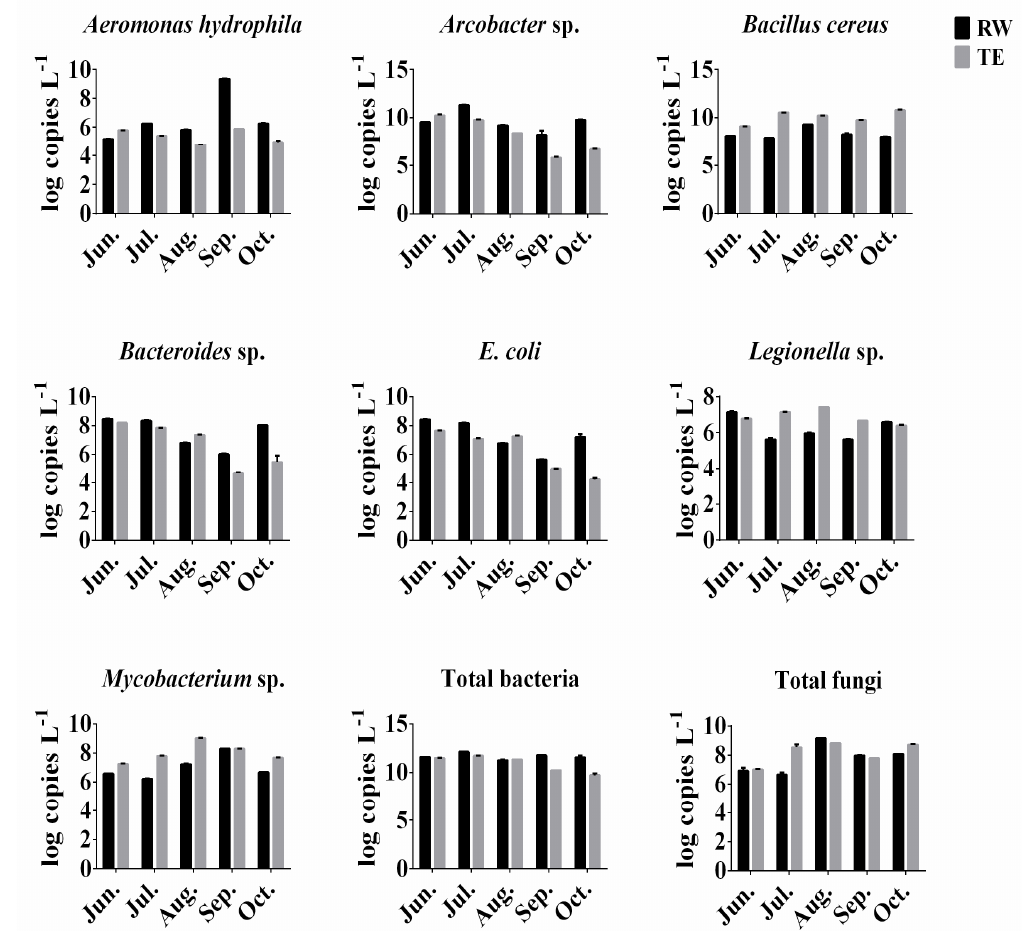
Figure 2. Pathogenic bacteria gene copy numbers in wastewater at different sampling stages (RW = raw wastewater, TE = treated effluent. Error bars indicate standard deviation from average, n = 3).